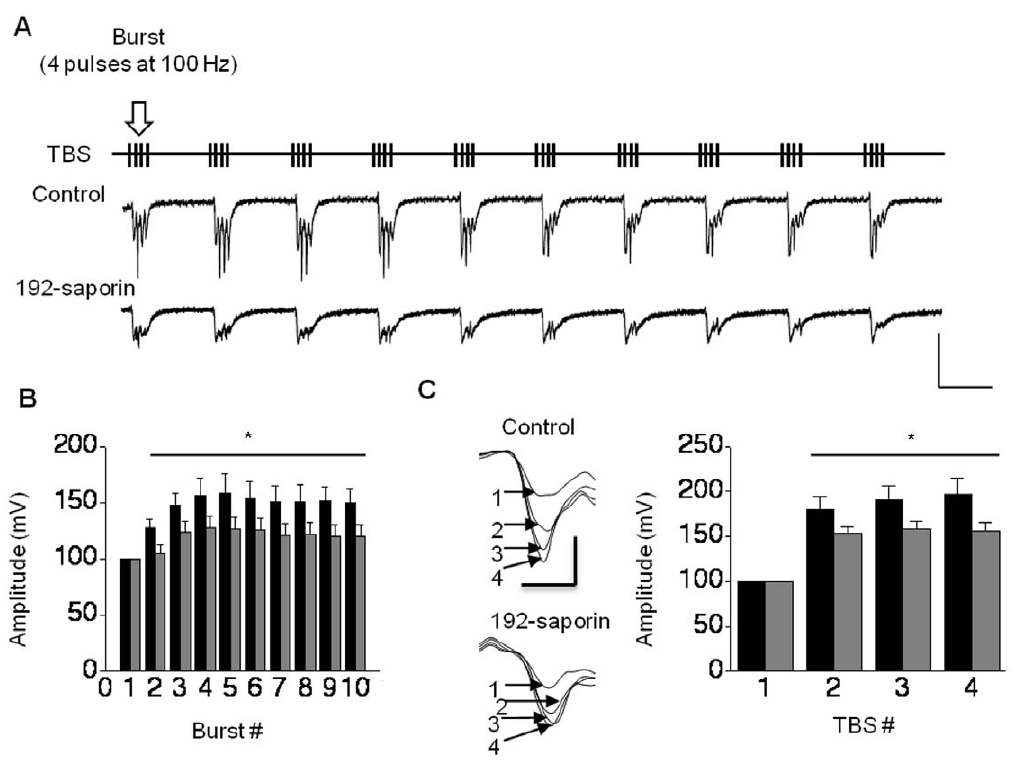
Figure 3. Reduction in the TBS facilitation in 192-saporin infused rats. (A) TBS stimulation protocol and samples of TBS induced traces from saline infused control and 192-saporin infused rats. (B) Bar chart exhibiting reduction of facilitation within the first TBS in 192-saporin infused rats (gray) compared to the controls (black); Calibration: 4 mV, 200 ms. (C) Facilitation of between TBS potentiation was impaired in 192-saporin infused rats (gray bars) compared to the saline infused controls (black bars) as shown by the sample traces and the bar chart. Sample traces are the fEPSPs in response to the first pulse in the first TBS. Calibration: 2 mV, 20 ms.